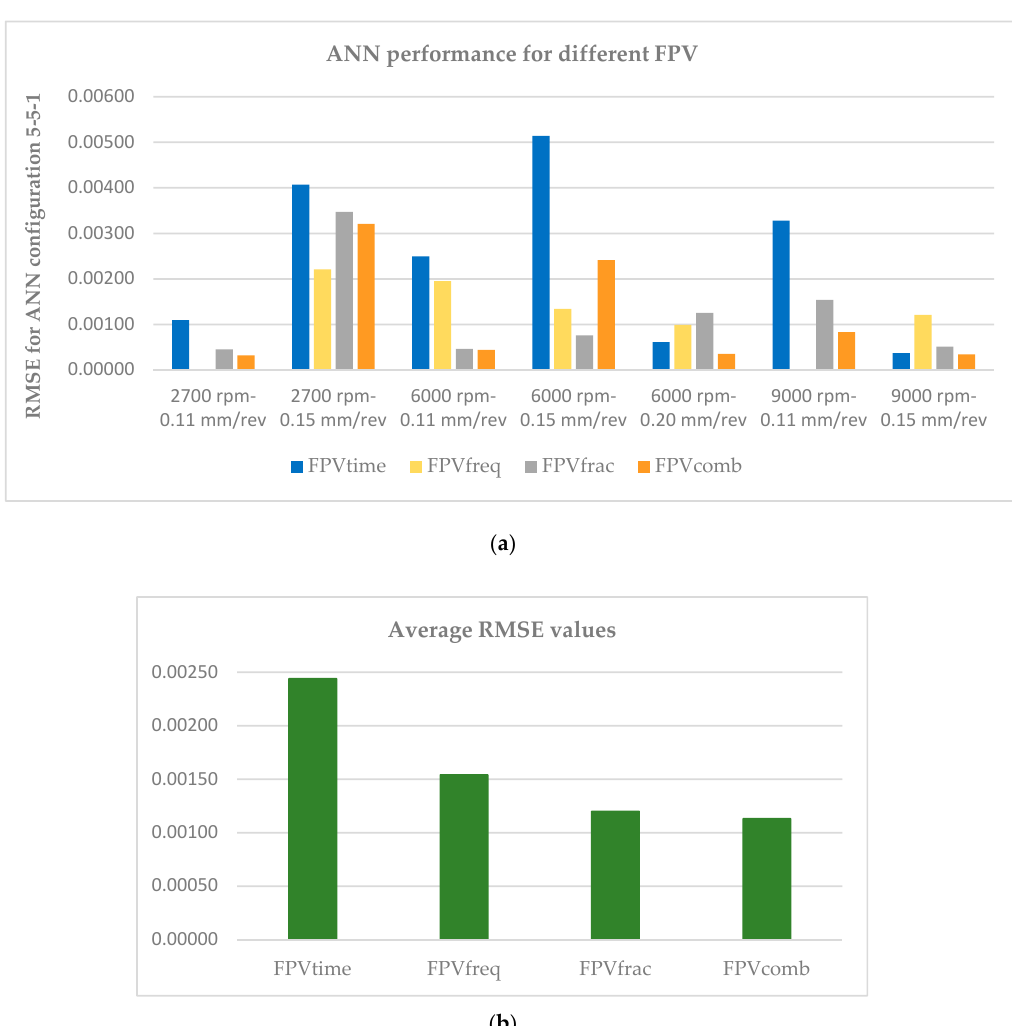
Figure 17. ( a ) RMSE values for the 5-5-1 ANN configuration for each drilling condition and for each constructed FPV; ( b ) RMSE average values for each constructed FPV.